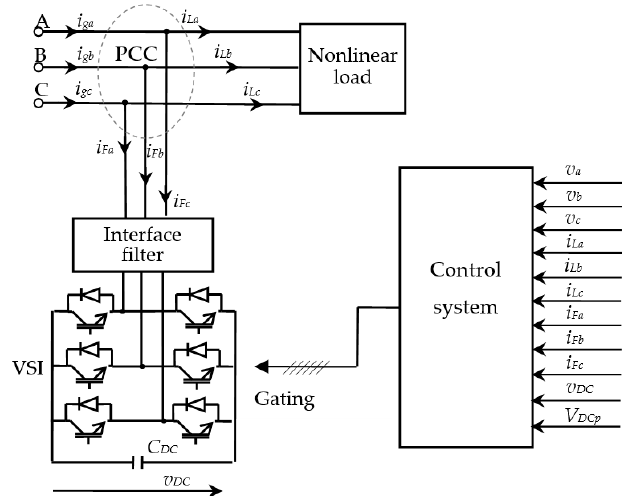
Figure 1. General structure of a three-phase shunt active power filter.